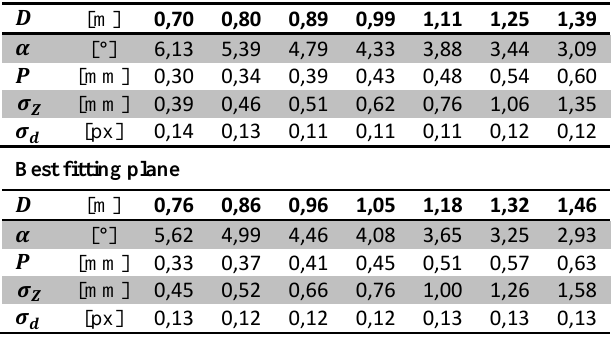
Table 1: Evaluation results. Distance , intersection angle , ground sampling distance , std. deviation at object and in image space